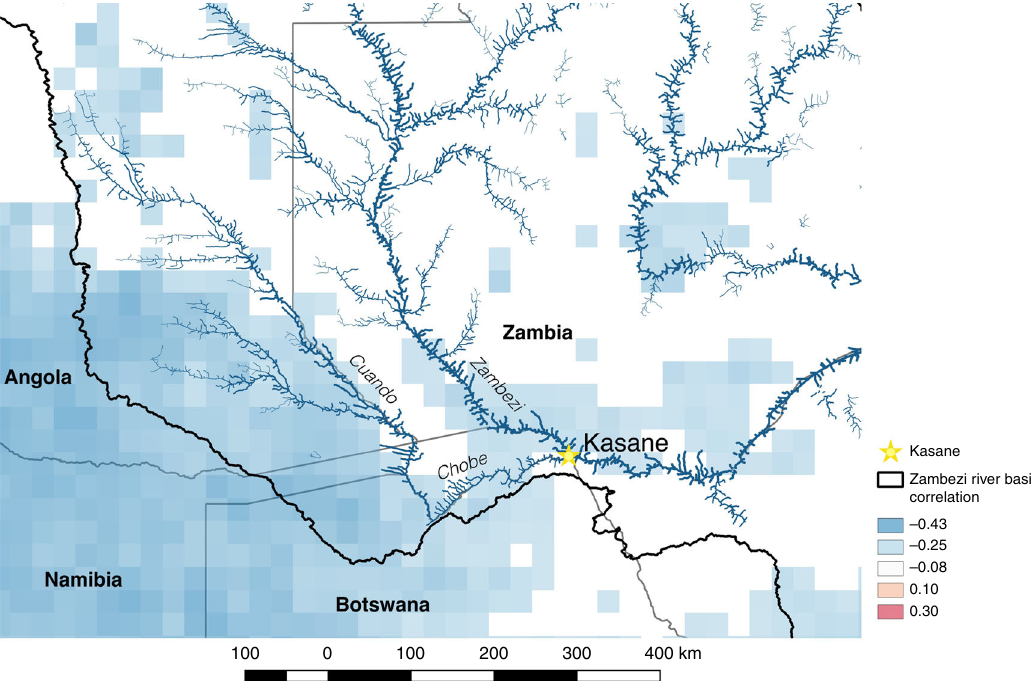
Fig. 3 Correlations between DJF Niño 3.4 and regional rainfall. Correlations between Niño 3.4 and satellite-measured regional rainfall in December, January, February from 1998 to 2015. Blue represents negative correlations and red represents positive correlations. The gold star locates Kasane, which is the largest town in Chobe District, and the black line outlines the Zambezi River Basin. Only correlations statistically signi fi cant at p <0.05 are shown on the